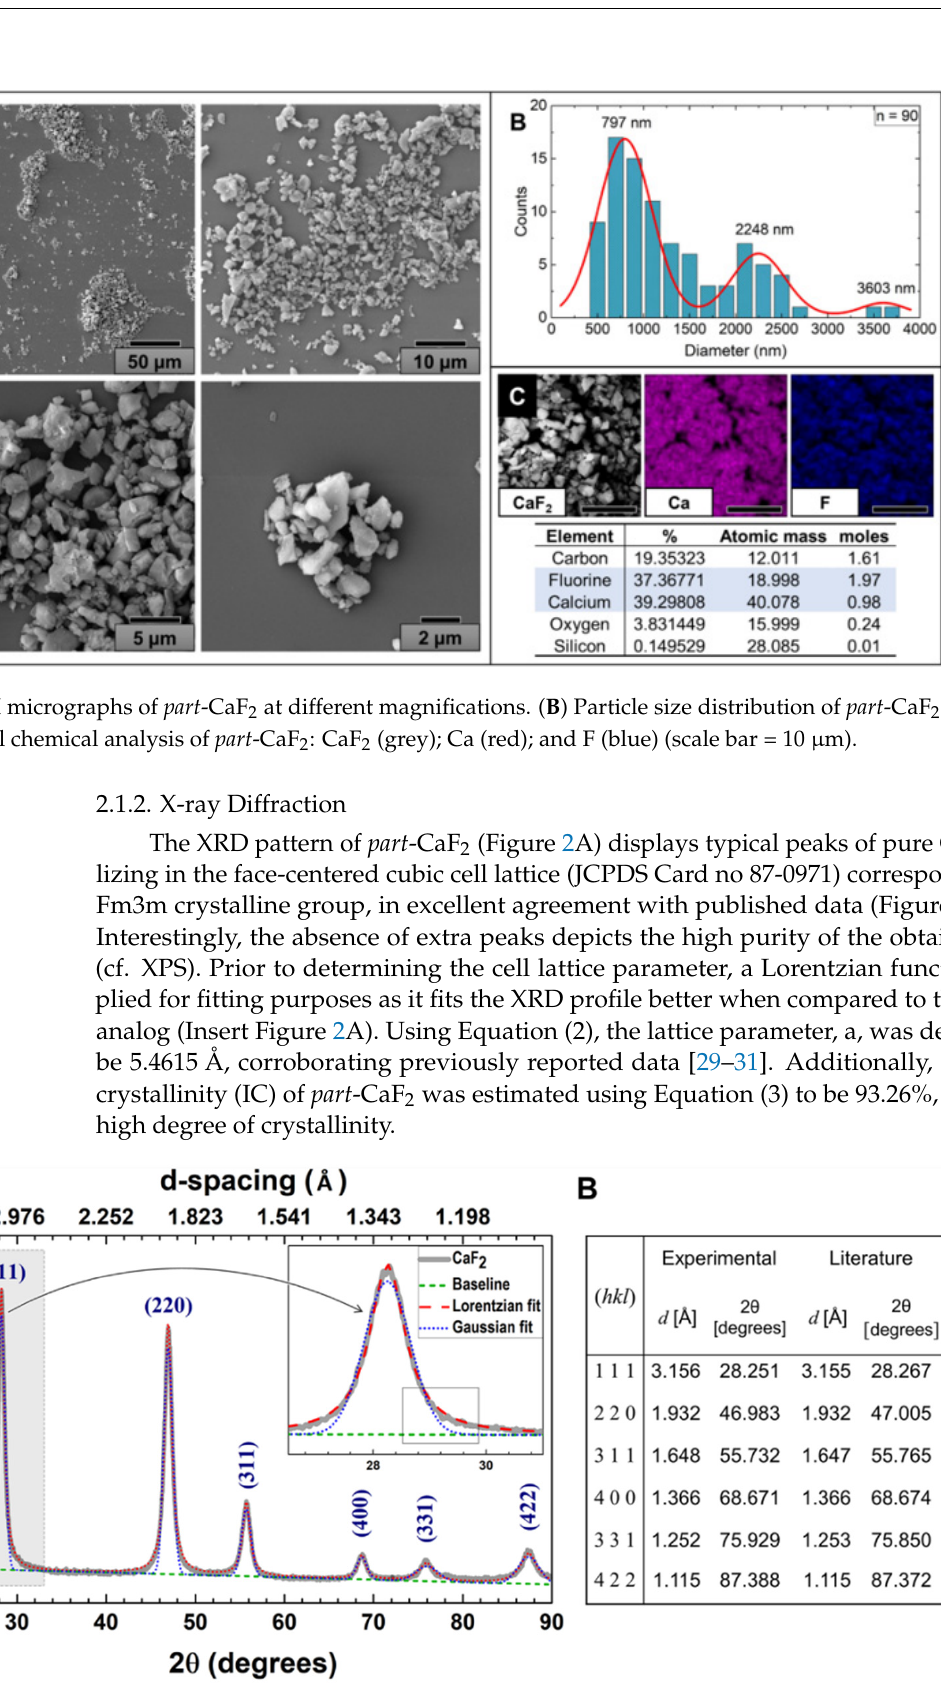
Figure 2. ( A ) Fitting of the part -CaF 2 XRD pattern. ( B ) Peak assignment regarding positions and interplanar distances compared with the literature (JCPDS Card no 87-0971).